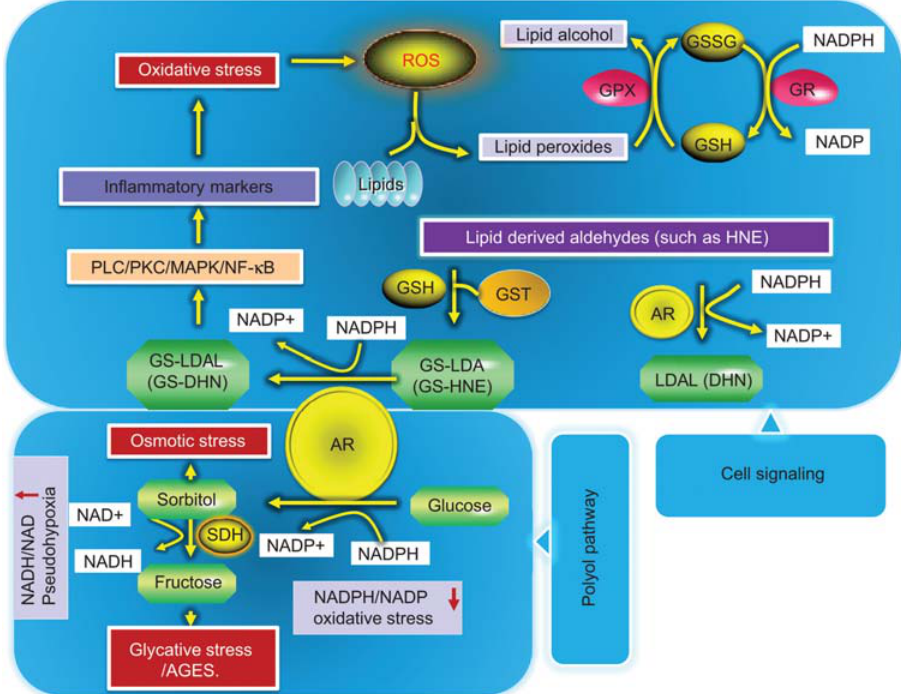
Figure 1 Aldose reductase regulates polyol pathway of glucose metabolism and lipid aldehyde mediated cell signaling. During hyperglycemia AR reduces glucose to sorbitol using NADPH as a cofactor and later sorbitol dehydrogenase (SDH) reduces sorbitol to fructose using NAD as a cofactor. AR causes oxidative stress by decreasing the ratio of NADP/NADPH and also competing with glutathione reductase (GR) for NADPH. Increased accumulation of sorbitol could cause osmotic stress. Metabolites of fructose increase AGE formation and cause glycative stress. Furthermore, during oxidative stress conditions, AR catalyzed lipid aldehyde reaction products mediate cellular signals via activation of redox sensitive transcription